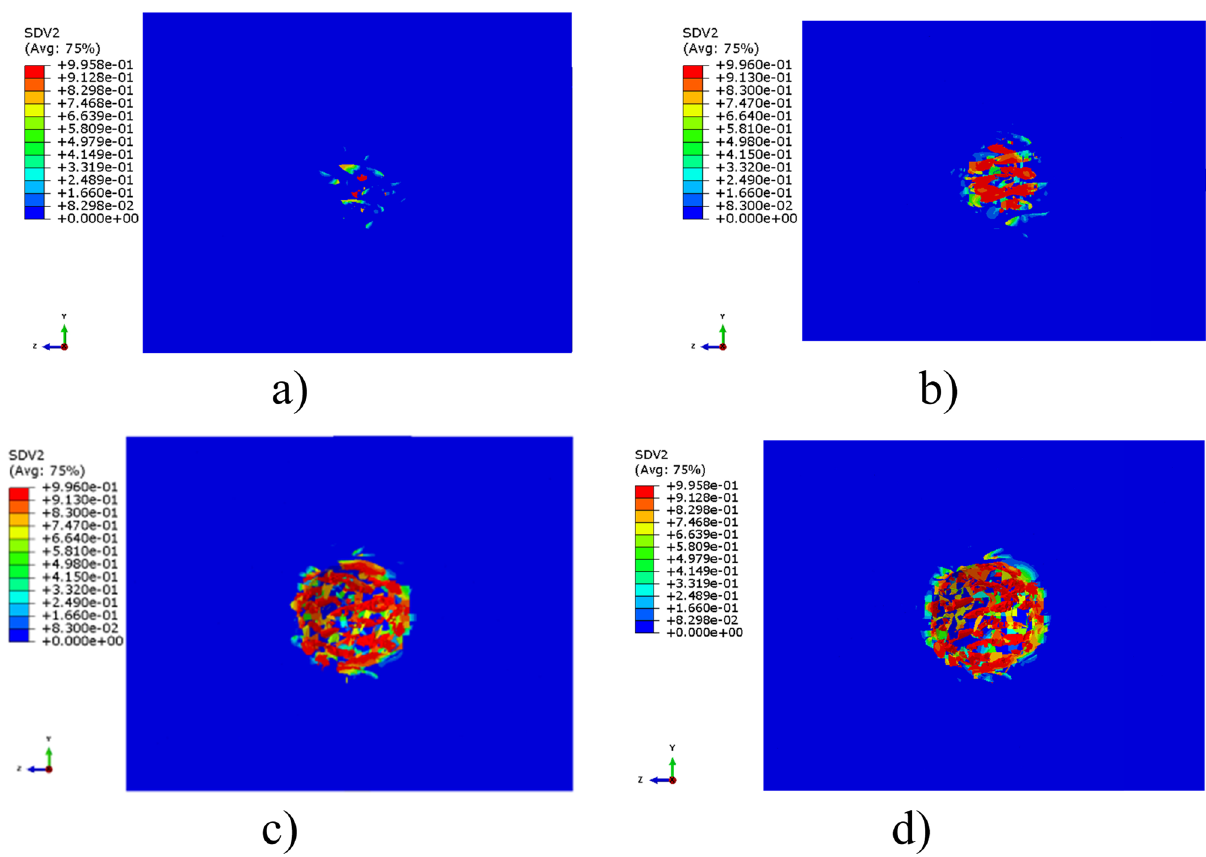
Figure 20: Longitudinal compression damage of the specimens after a di ff erent number of impact tests: ( a ) 1st impact, ( b ) 5th impact, ( c ) 10th impact, and ( d ) 20th